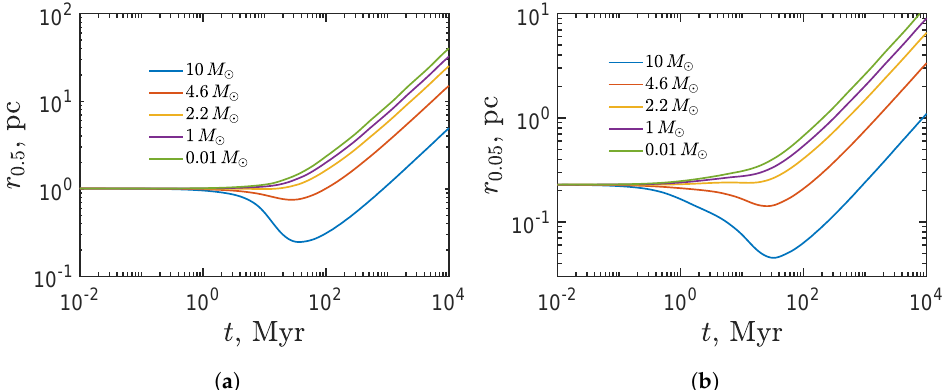
Figure 5. The evolution of mass shells containing 50 ( a ) and 5 ( b ) percent of the mass for different types of PBHs is